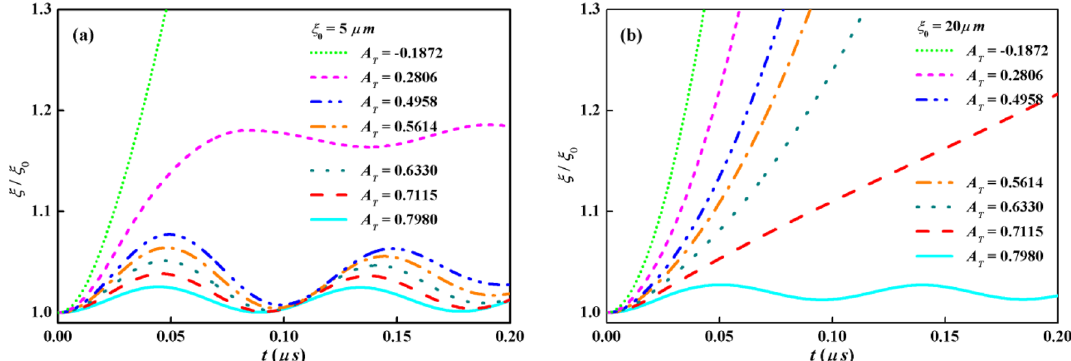
Figure 7. Growth factors vs time with A T = 0.7980, 0.7115, 0.6330, 0.5614, 0.4958, 0.2806 and − 0.1872 with different